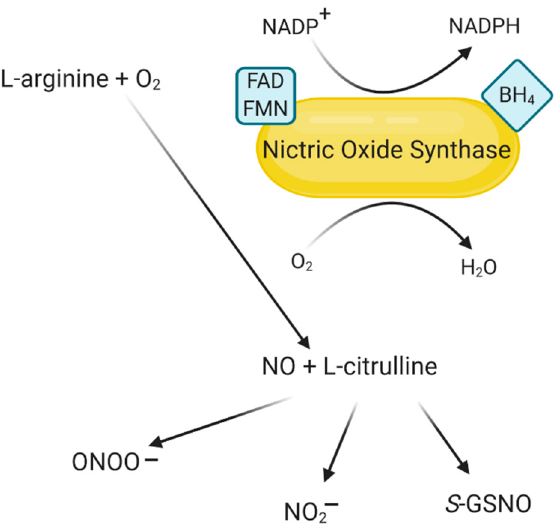
Figure 2. Synthesis of NO and related products. Modified based on [55–57]. Created with BioRender.com. Legend: FAD—flavin adenine dinucleotide; FMN—flavin mononucleotide; BH 4 —tetrahydrobiopterin; H 2 O—water; NADP + —glutamate dehydrogenase; NADPH—reduced nicotinamide adenine dinucleotide phosphate; O 2 —oxygen; S-GSNO—S-nitrosoglutathione.